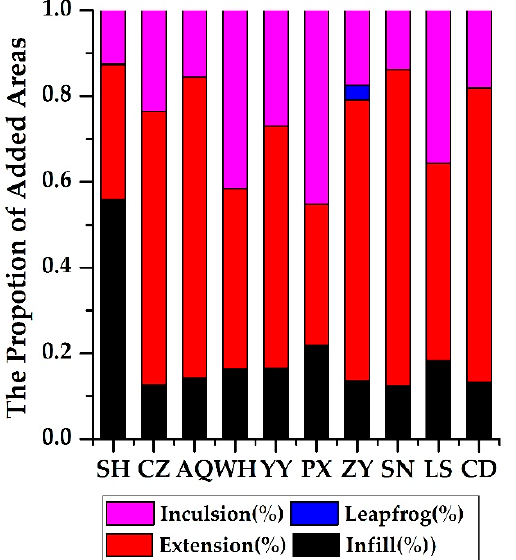
Figure A2. Patterns of the added urban areas at the ten prefecture-level cities of the YRB from 2000 to 2013. Similar to the urban form data, the datasets are also provided by the NYU Urban Expansion Program (http://datatoolkits.lincolninst.edu/subcenters/atlas-urban-expansion/).